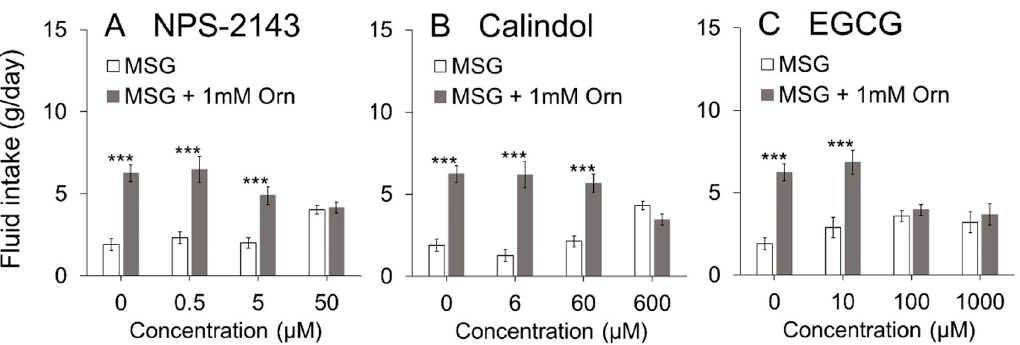
Figure 5. Effects of GPRC6A antagonists on the amount of intake of 0.05 M MSG with and without 1 mM L-ornithine (Orn). Each of the antagonists, ( A ) NPS-2143, ( B ) Calindol and ( C ) EGCG, dose-dependently suppressed. Each of the antagonists (NPS-2143, calindol and EGCG) dose-dependently suppressed Orn-induced preference. Each value is mean ± SE; n = 8. *** p < 0.001.